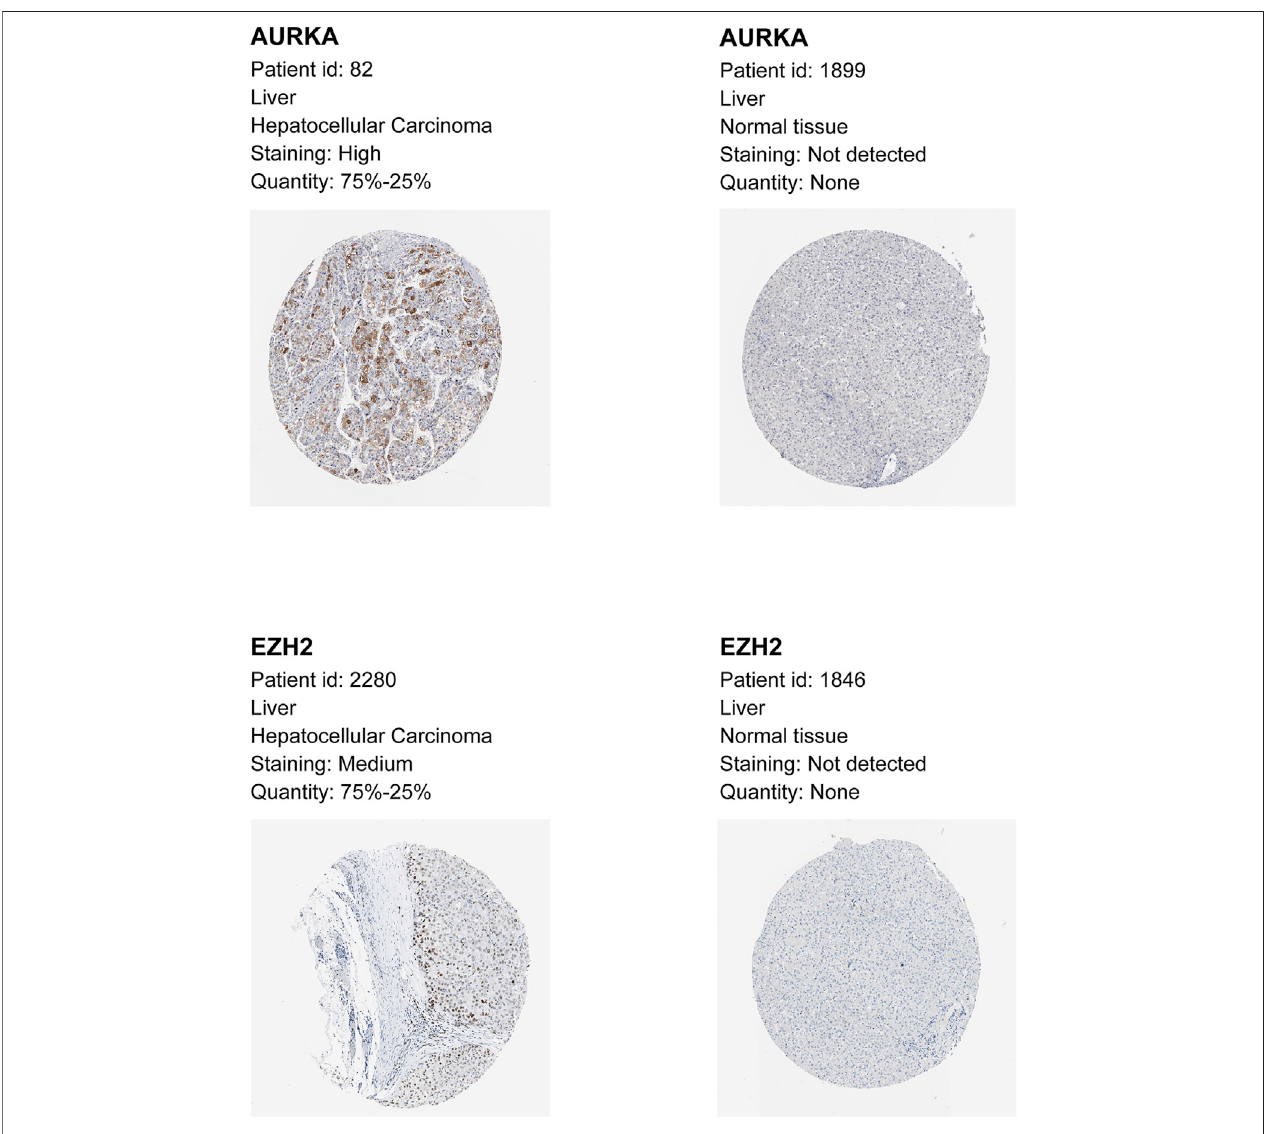
FIGURE 6 | Immunohistochemistry (IHC) data of AURKA and EZH2 from the Human Protein Atlas. Higher expression of AURKA and EZH2 by immunohistochemistry in HCC compared with normal tissue.